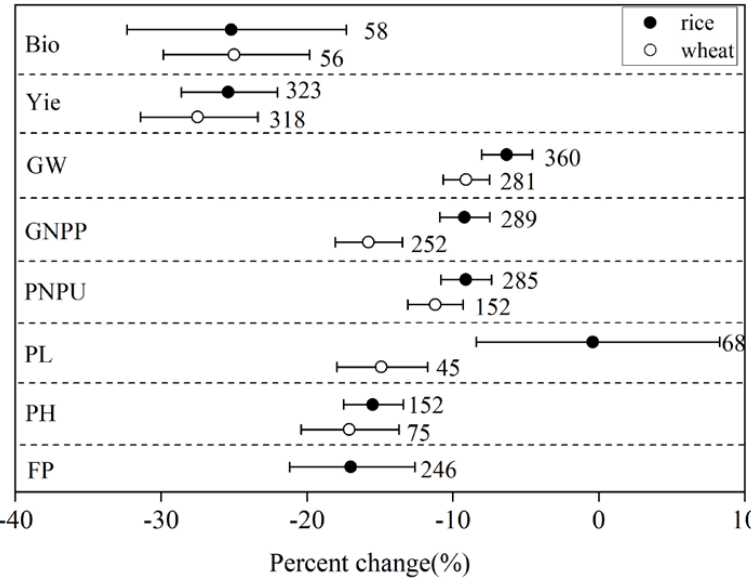
Figure 1. Effect of drought on the agronomic traits of rice and wheat. Numbers near the symbols specify the number of data points and the error bars indicate a 95% confidence interval. Abbreviations for the agronomic traits are described in Table 2. Int. J. Environ. Res. Public Health 2018 , 15 , x